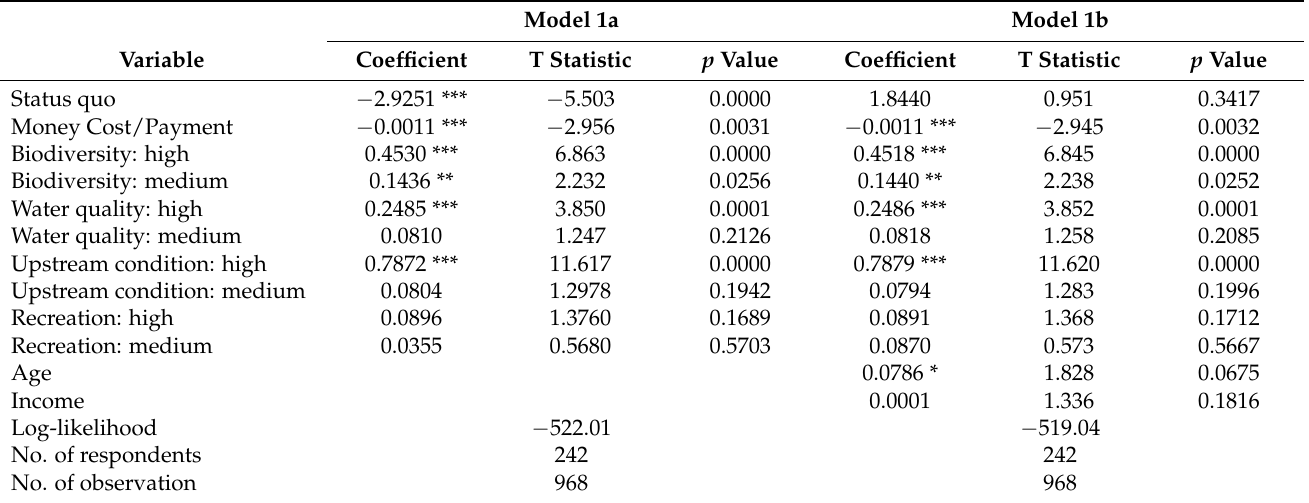
Table 6. The CL coefficient estimates for the WO case’s money treatment using two models: no socioeconomic factors (Model 1a) and socioeconomic variables (Model